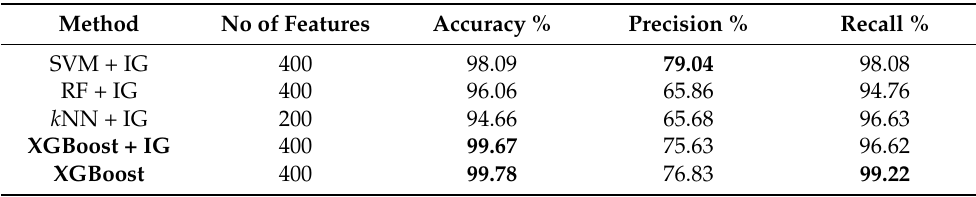
Table A1. Comparison of classification results for Data2.